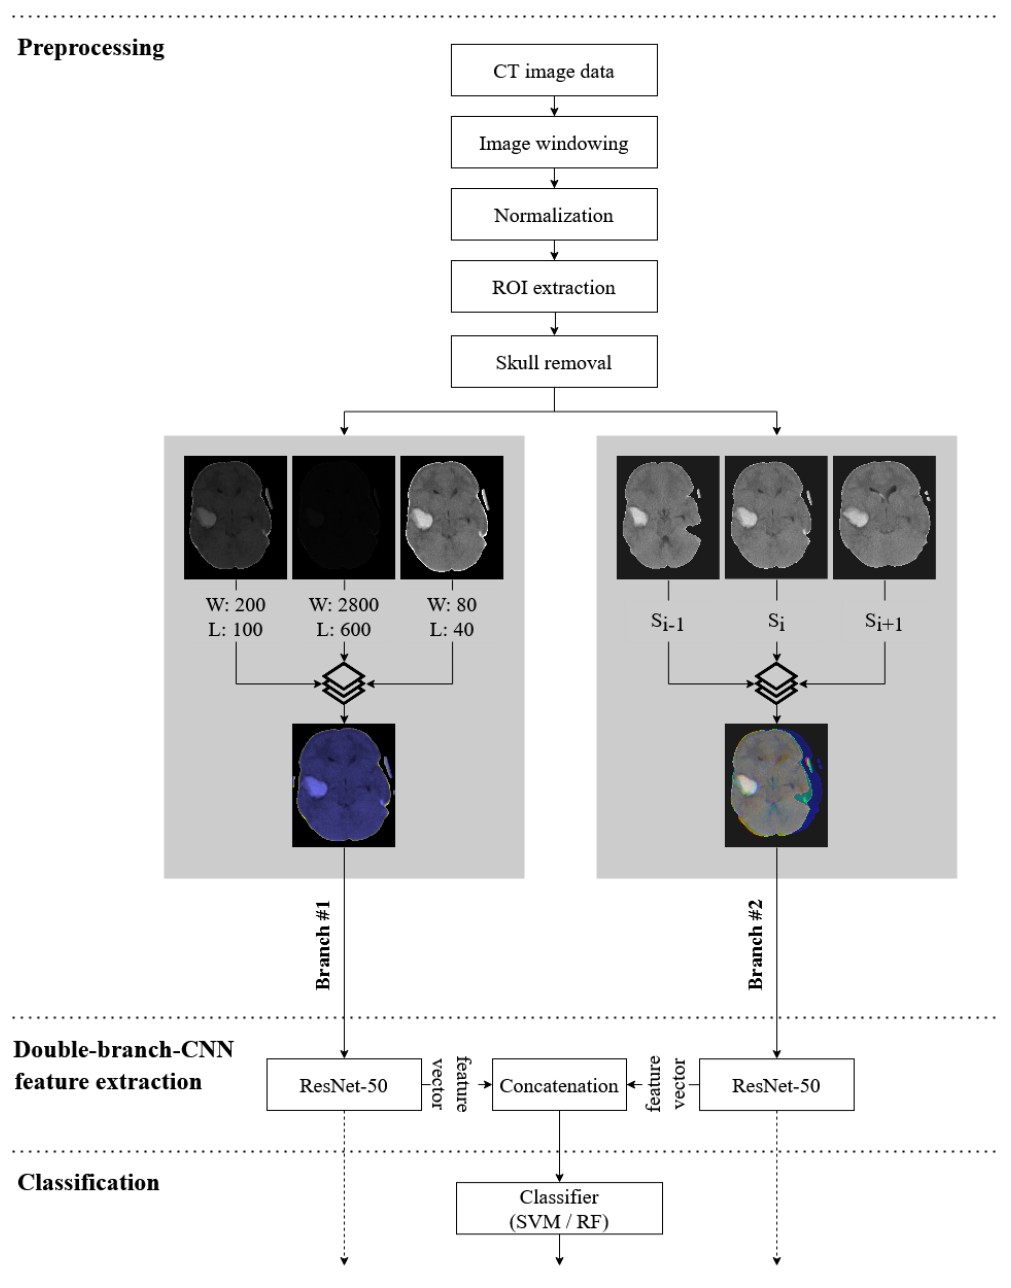
Figure 2. General scheme of a proposed hemorrhage detection model. The same architecture applies for each classification task (five ICH subtypes vs. healthy brain). The preprocessing is a common step for all five